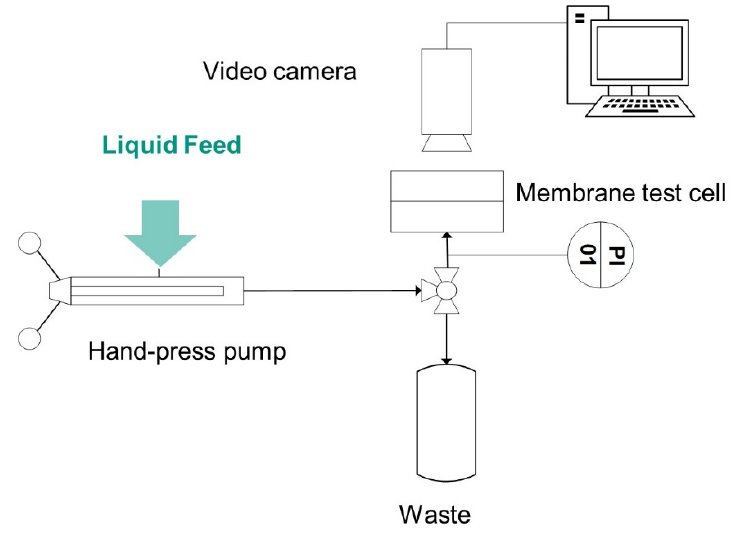
Figure 2. Overview of the experimental set-up used to measure the LEP using the Visual Method.